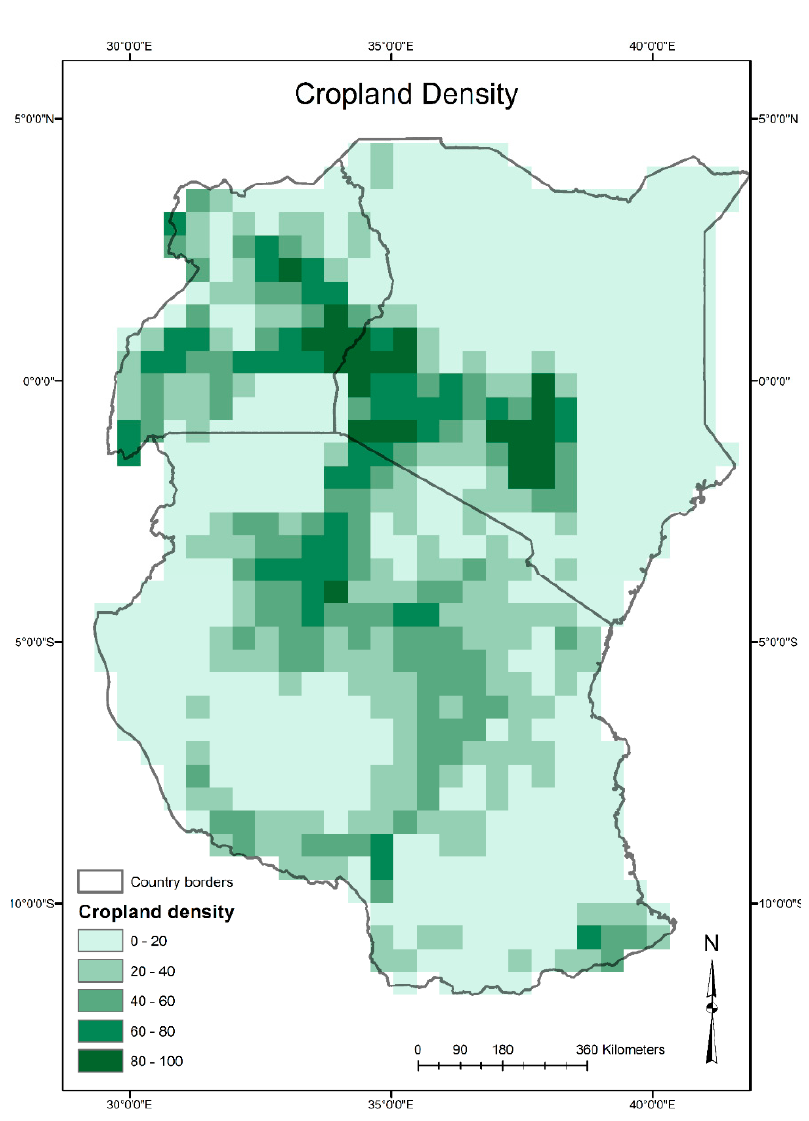
Figure 2. The distribution of cropland density—computed as a percent of cropland per 0.44° × 0.44° grid cell. This is input data for the stratification of cropping intensity.